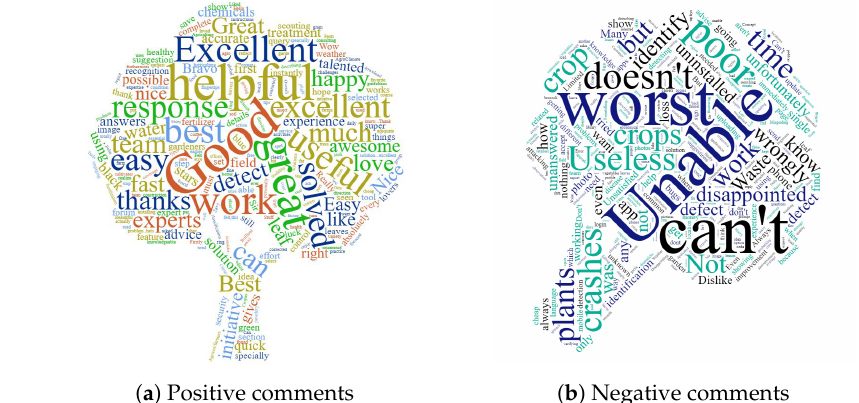
Figure 10. Word cloud of positive and negative